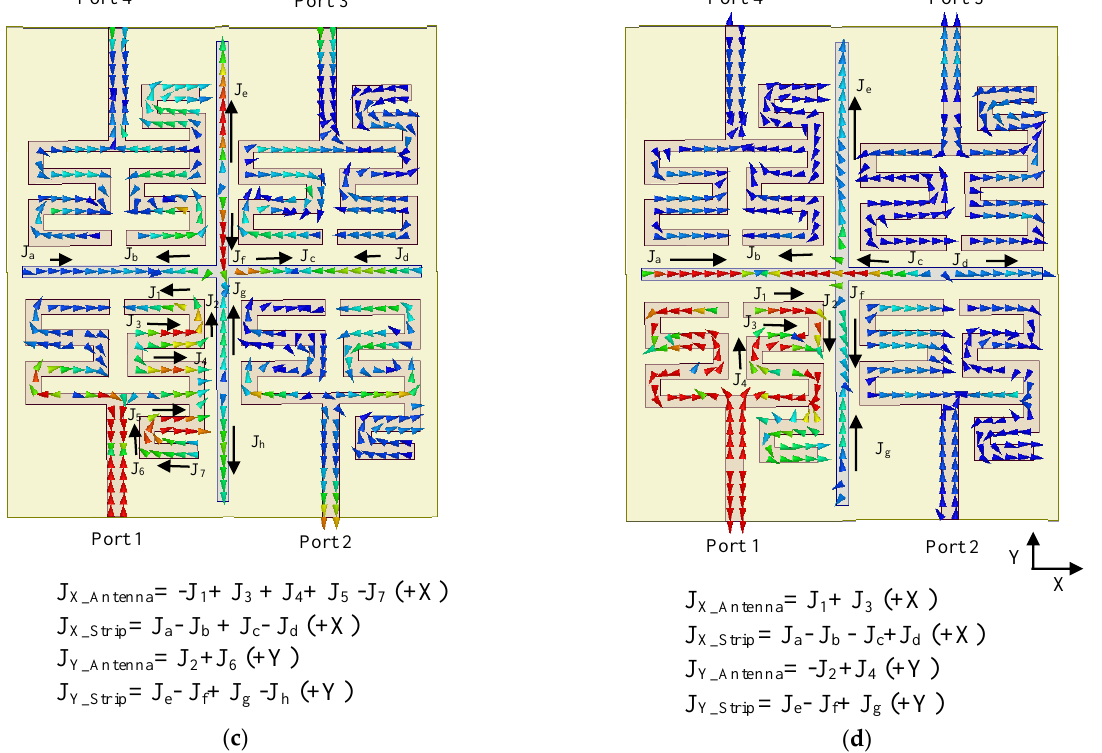
Figure 8. Current distribution of MIMO antenna with cross parasitic microstrip line structure at ( a ) 1st resonance, ( b ) 2nd resonance, ( c ) 3rd resonance and ( d ) 4th resonance.